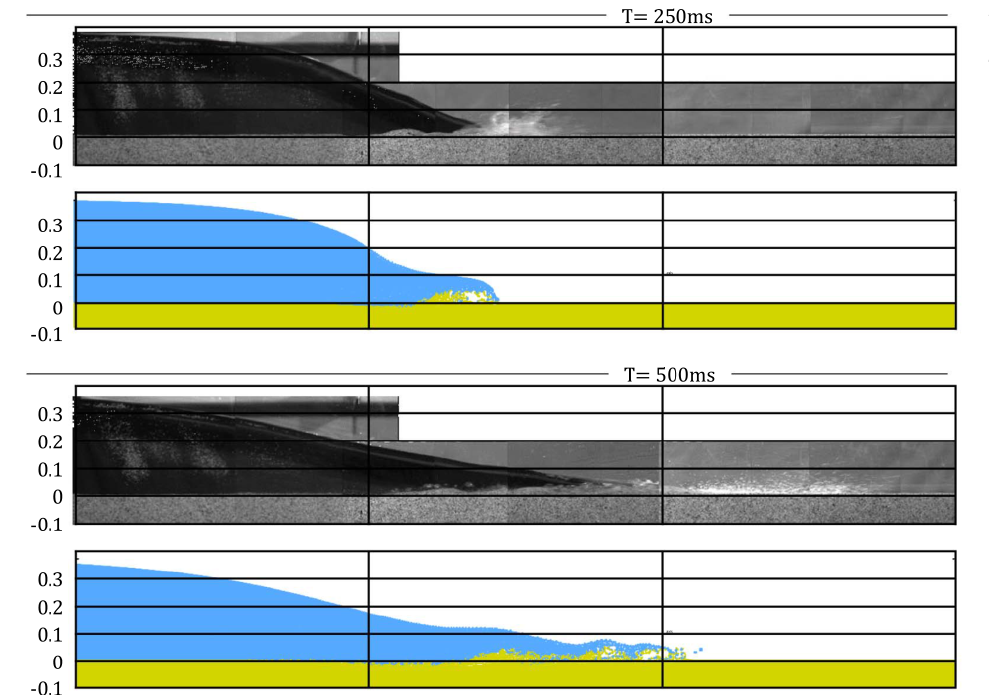
Figure 18. The dam-break flow on sand beds (black: experimental results; blue: SPH simulation results)